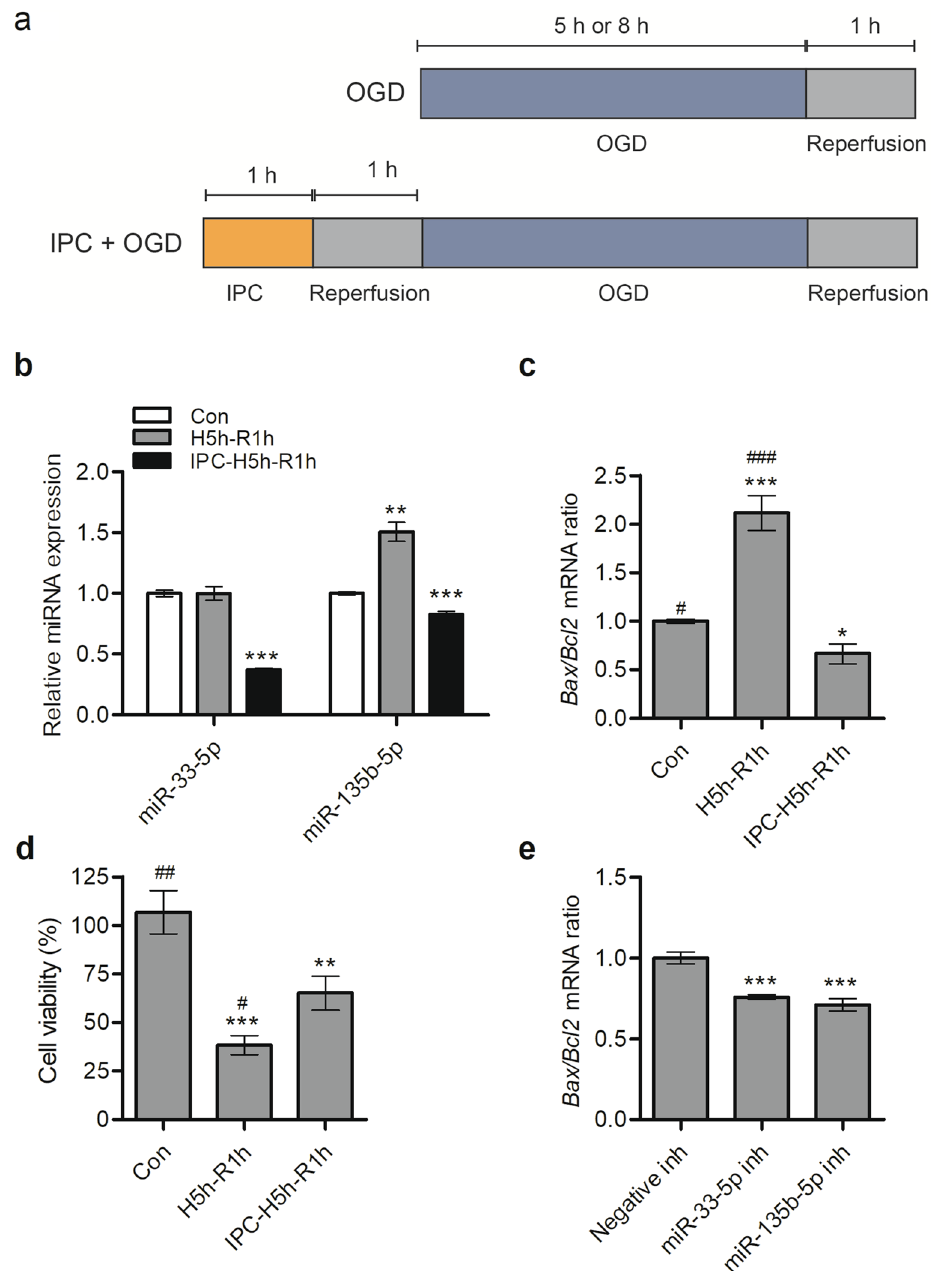
Figure 3. Neuroprotective effects by downregulation of miR-33-5p and miR-135b-5p. ( a ) Experimental timeline for treatment of OGD and IPC + OGD in Neuro-2a cells. ( b ) After treatment of OGD or IPC + OGD, expression levels of two miRNAs (miR-33-5p and miR-135b-5p) were determined using RT-qPCR. ( c ) After treatment of OGD or IPC + OGD, mRNA levels of pro-apoptotic Bax and anti-apoptotic Bcl2 were determined by RT-qPCR and expressed as Bax/Bcl2 mRNA ratios. ( d ) After treatment of OGD or IPC + OGD, cell viability was determined by CCK-8 assay. ( e ) To suppress the function of each miRNA, Neuro-2a cells were transfected with either miR-33-5p inhibitor, miR-135b-5p inhibitor, or a relevant negative-control inhibitor. Twenty-four hours after transfection, cells were subjected to OGD. Expression of pro-apoptotic Bax and anti-apoptotic Bcl2 mRNA were determined by RT-qPCR and expressed as Bax/Bcl2 mRNA ratios. Values are mean ± standard deviation for n = 3. Statistical analyses were performed using one-way analysis of variance followed by Dunnett’s multiple comparison test using control (*), negative inhibitor (*), or IPC + OGD (#) (* = p < 0.05, ** = p < 0.01, *** = p < 0.001, # = p < 0.05, ## = p < 0.01, ### = p < 0.001). Abbreviations: OGD, oxygen–glucose deprivation; IPC, ischemic preconditioning; miRNA, micro ribonucleic acid; RT-qPCR, reverse transcription-quantitative polymerase chain reaction; Bax, Bcl2 associated X; Bcl2, B-cell lymphoma 2; mRNA, messenger ribonucleic acid; CCK-8, cell counting kit-8; H5h, hypoxic incubation for 5 h; R1h, reperfusion for 1 h; inh,